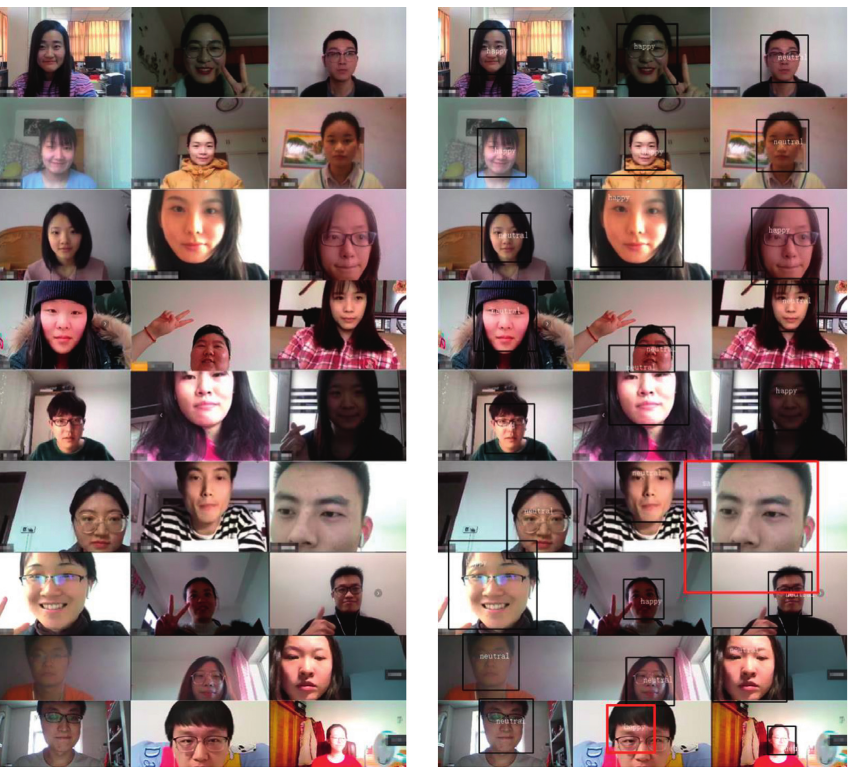
Figure 6: The input (a) and output (b) images of the FER model.